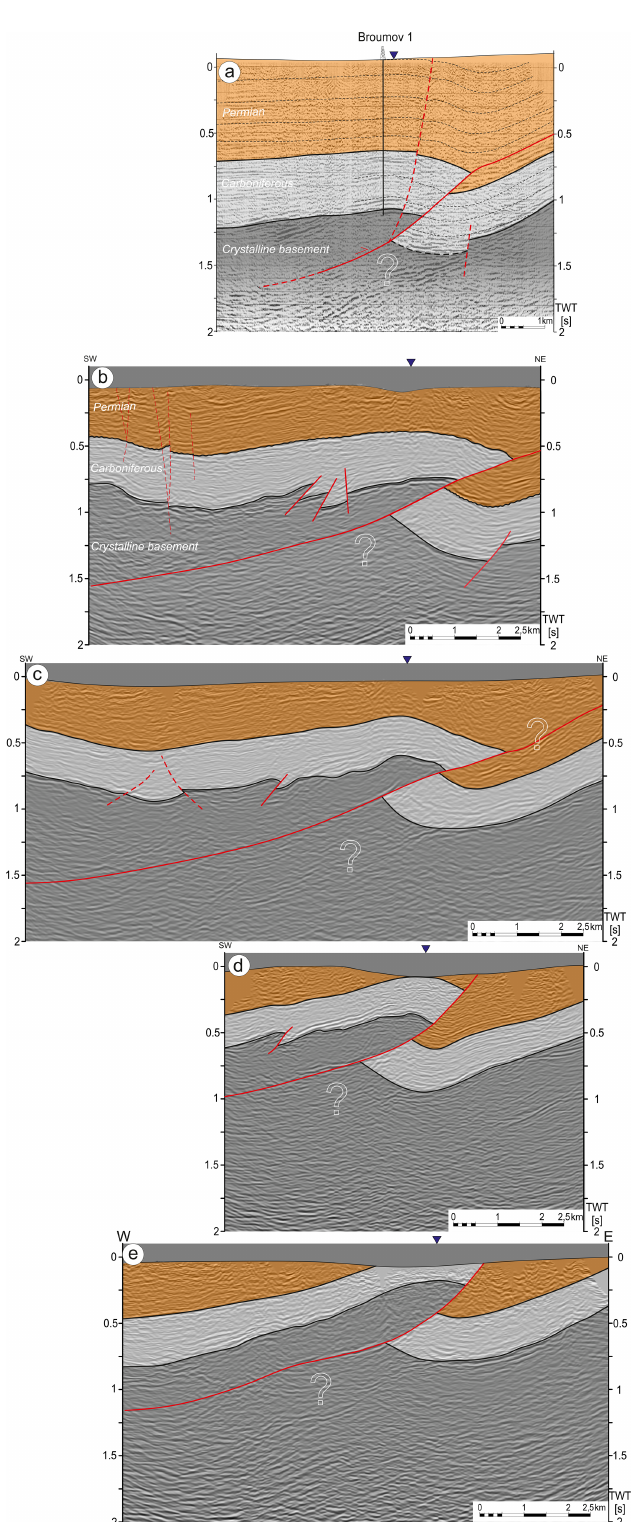
Figure 13. Seismic profiles from the vicinity of Broumov (paper print version – Brada et al., 1982) (a) and from the vicinity of Radków, all arranged consecutively from NW to SE (b–e) . Location in Fig. 11. The section in (a) shows that the Broumov well was drilled in the hanging wall of a thrust fault, and, hence, the Carboniferous in the neighbourhood may occur deeper than found in the well. The thrust continues to the NE parallel to the bedding – most probably as a decollement or detachment along the lower Permian Anthracosia Shale member.